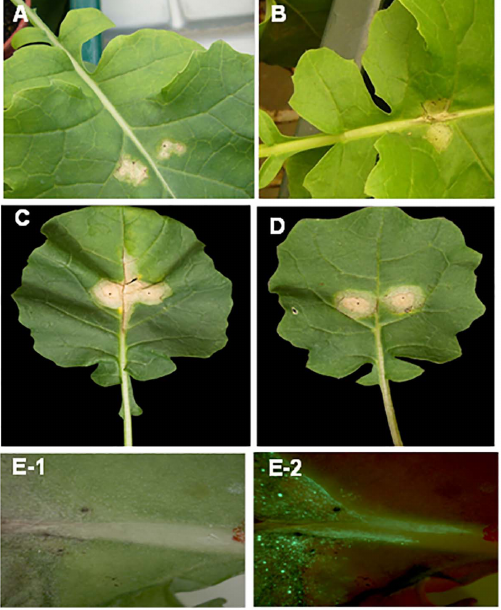
Figure 3. Phoma leaf spot symptoms produced in controlled conditions . Phoma leaf spot symptoms on leaves of doubled haploid lines A30 (susceptible) or C119 (with quantitative resistance) inoculated with conidia or ascospores of Leptosphaeria maculans . Lesions on leaves of A30 at 15 days post inoculation (dpi) with conidia (A) or 10 dpi with ascospores (B); lesions on leaves of A30 (C) and C119 (D) at 22 dpi; symptomless growth of GFP-expressing L. maculans (isolate ME24/3.13) along a leaf vein towards the petiole of A30 viewed with brightfield illumination (E-1) or a GFP filter (E-2) at 18 dpi.